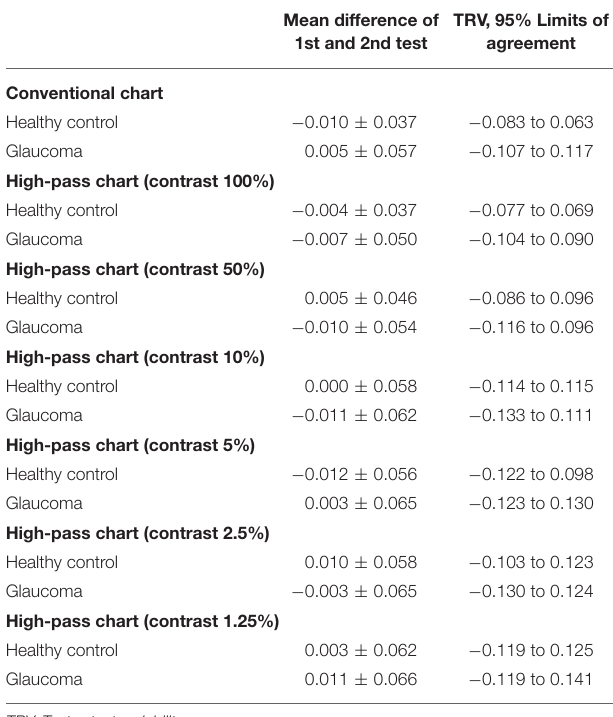
TABLE 1 | Test-retest reliability of the conventional chart and the novel high-pass charts.